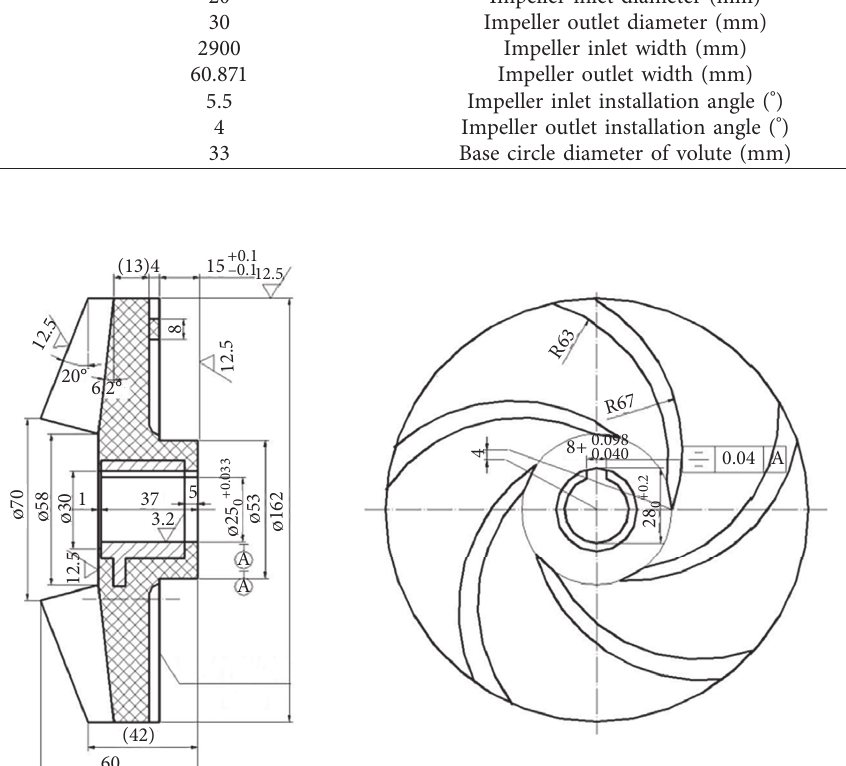
Figure 6: Two-dimensional diagram of the impeller.